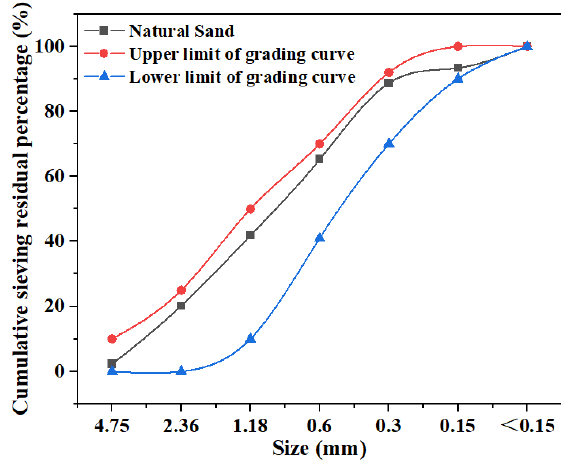
Figure 2. Sieve analysis of the natural sand. The test uses crushed stone produced in Rizhao, Shandong Province. The elongated and flaky particle content and crushing value index of the crushed stone were 7.4% and 16.5%. The apparent density, bulk density, and tight density of the crushed stone were 2720 kg/m 3 , 1400 kg/m 3 , and 1550 kg/m 3 . The sieving residual percentage of the crushed stone is shown in Table 5. Table 5. Sieving residual percentage of the crushed stone.